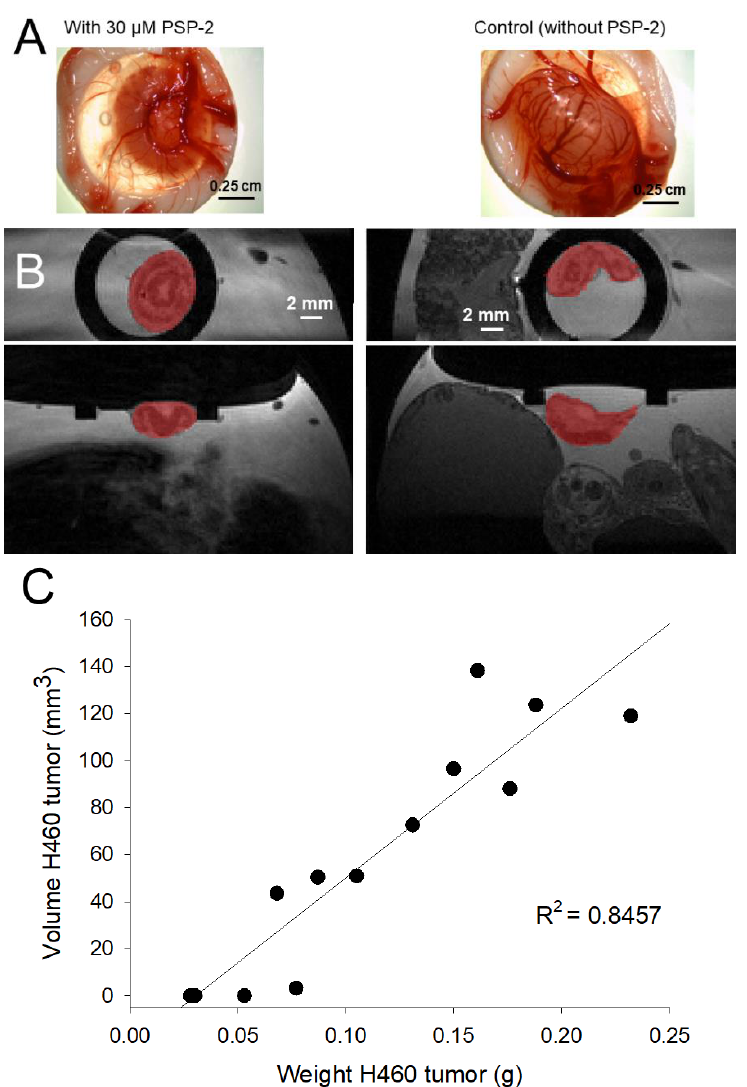
Figure 2. Representative images of H460 tumors after fixation ( A ) and the corresponding MRI images of H460 tumors (grown on living chicken embryos) used to assess their volumes (red colored area) ( B ). Linear correlation between the MRI tumor volume and the weight after formaldehyde fixation, excision, and deprivation of the surrounding tissue ( C ).